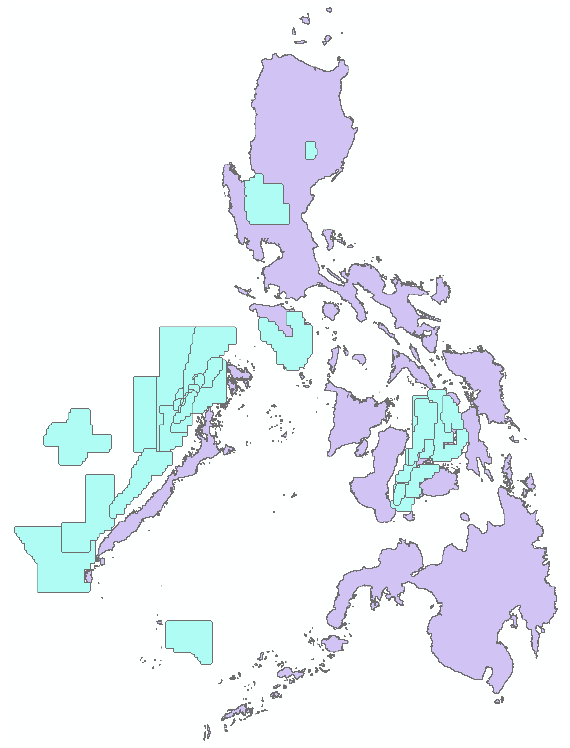
Figure 7. Oil and gas extraction areas.